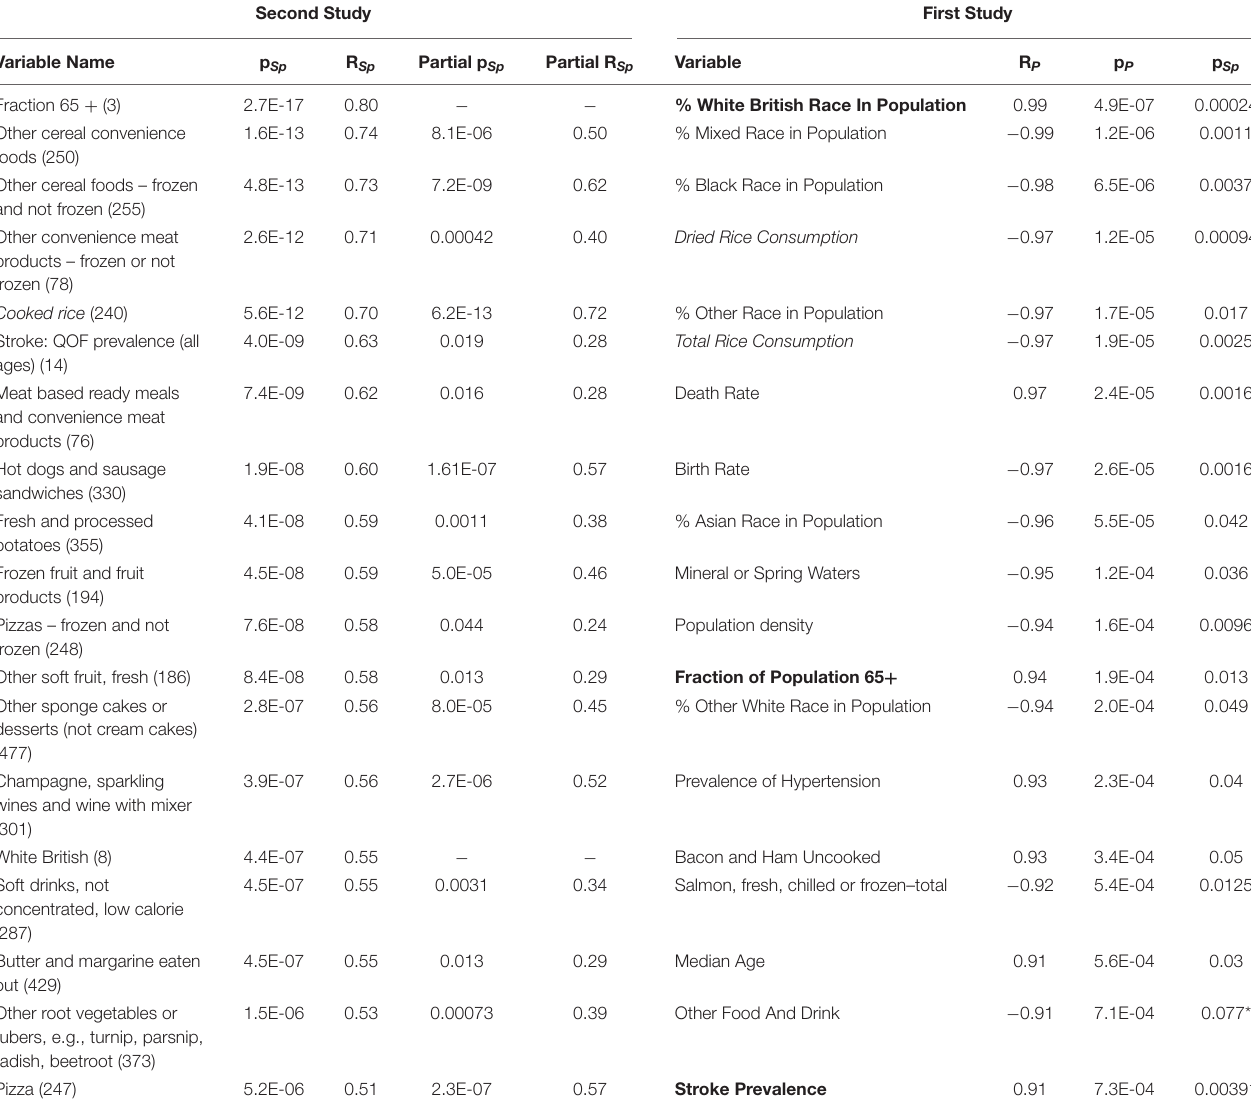
TABLE 2 | Univariate relationships between study variables and dementia in the first and second study. Second